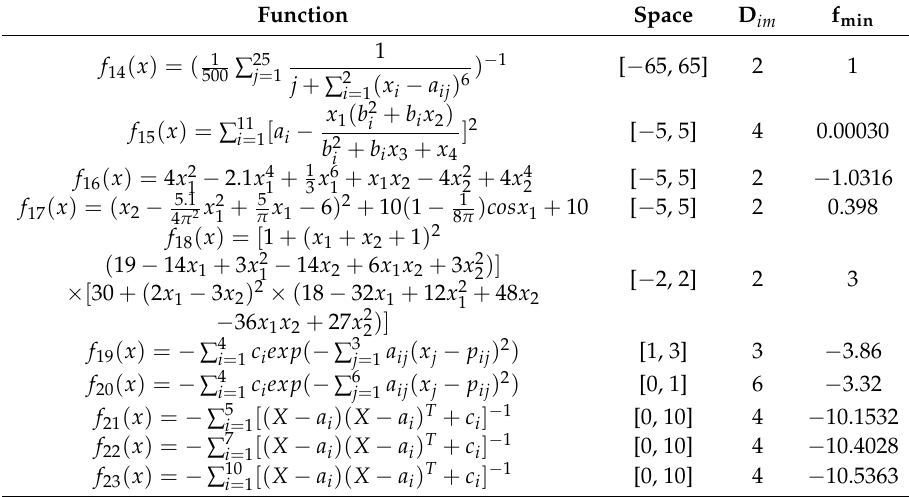
Table 3. Fixed-dimension multimodal benchmark